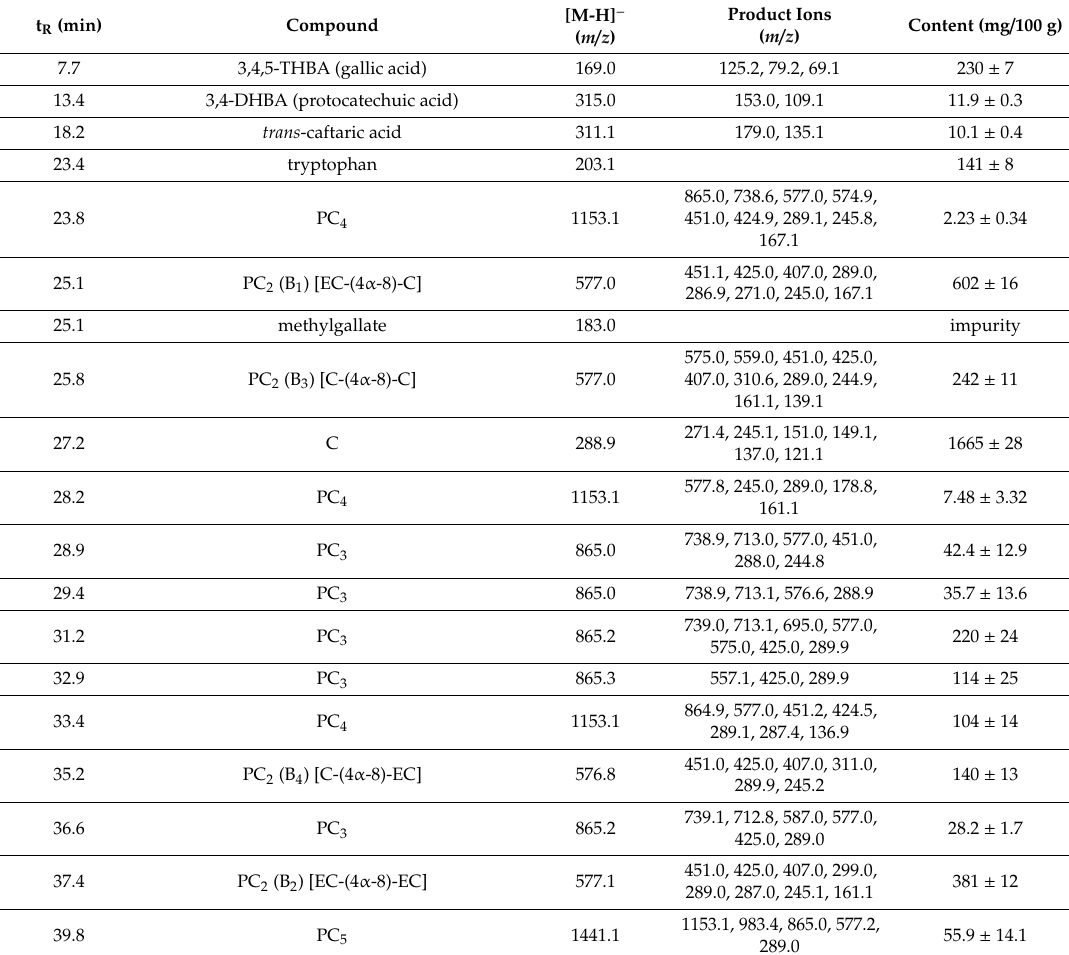
Table 1. UV absorption and mass spectroscopic data (negative ionization mode) of the identified compounds in the food-grade GSE (contents are expressed as mg / 100 g